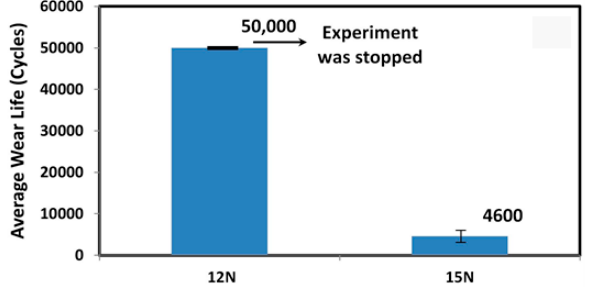
Figure 6. Average wear life of U1.5C coating recorded after a wear test conducted at a normal load of 15 N and a sliding velocity of 0.1 m/s for 50,000 cycles.3.5. Development and Characterization of the Hybrid Nanocomposite Coating.